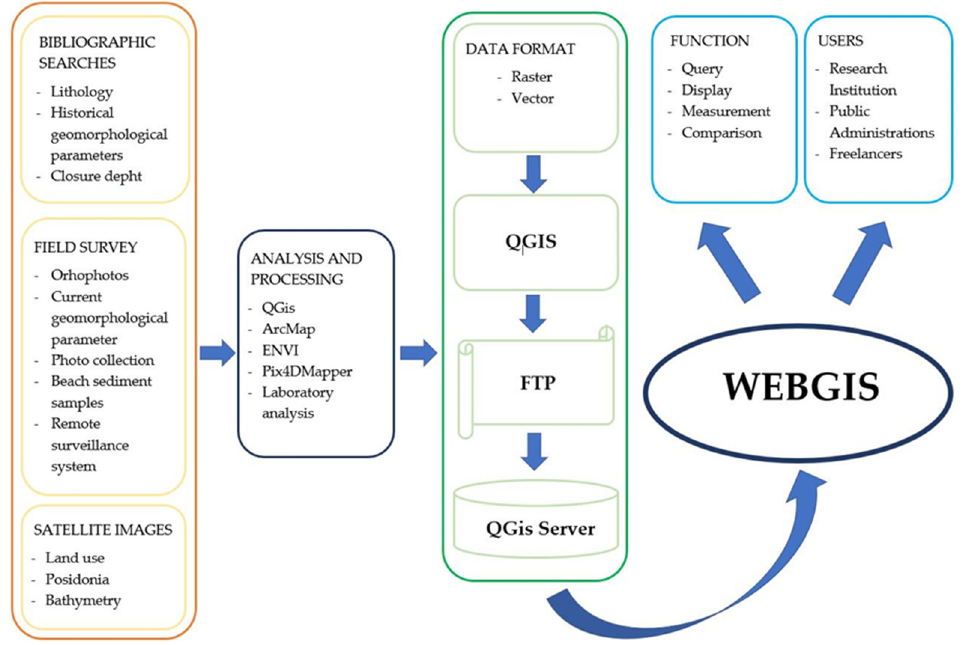
Figure 3. Chart flow methodology of BESS WebGIS implementation.